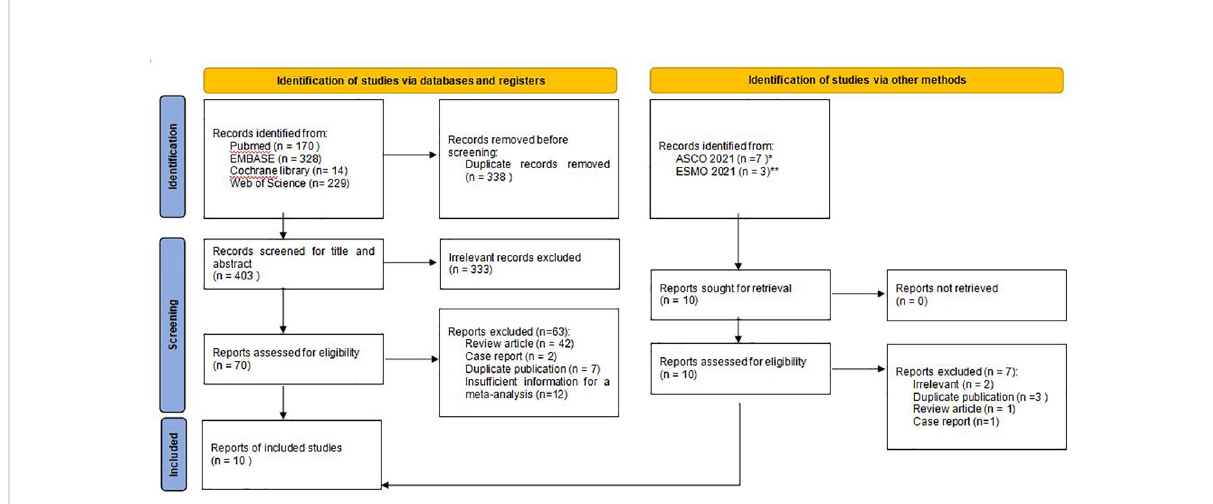
FIGURE 1 Flow chart of study selection. ASCO*: American Society of Clinical Oncology; ESMO**: European Society for Medical